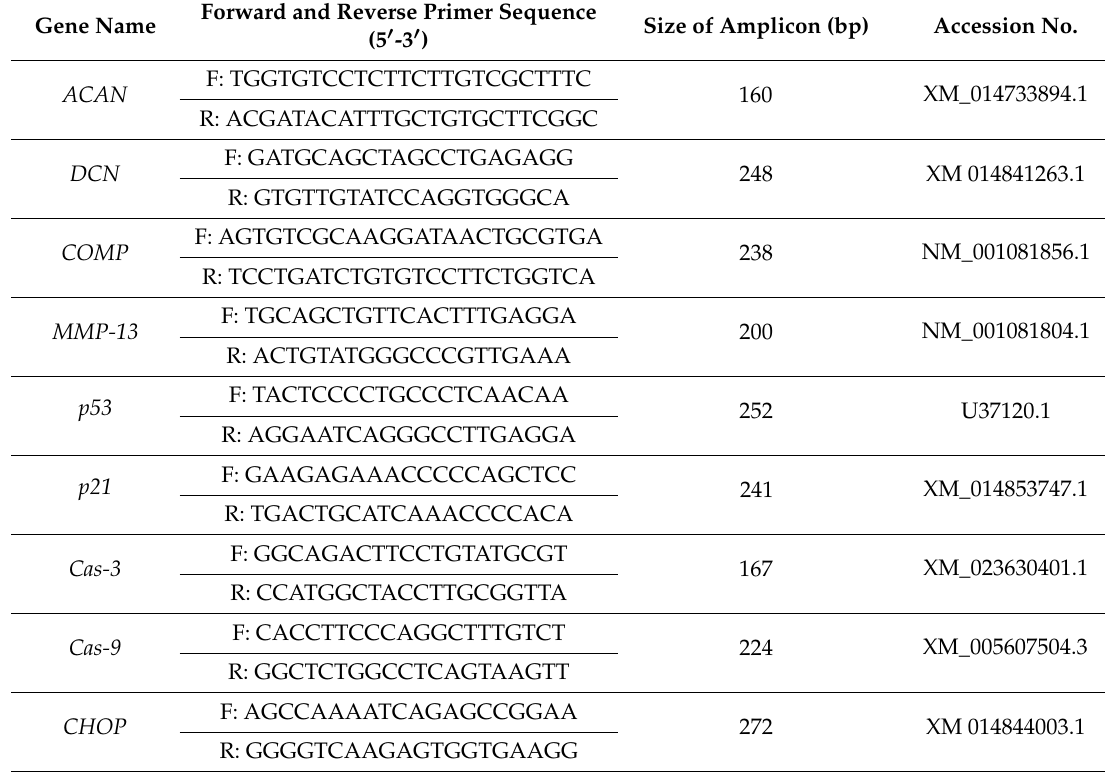
Table 1. Sequences of primers used in reverse transcription polymerase chain reaction